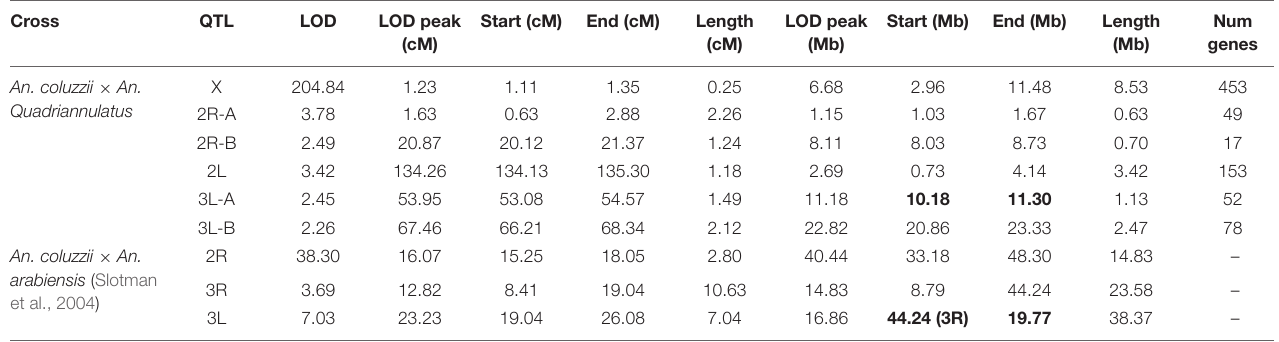
Start an end positions indicate the 1.5 LOD intervals of QTL locations (LOD peak). Bold values indicate overlapping QTL between the crosses on the 3L, a region of the An. coluzzii genome that contributes to hybrid male sterility when introgressed into both An. quadriannulatus and An. arabiensis genetic